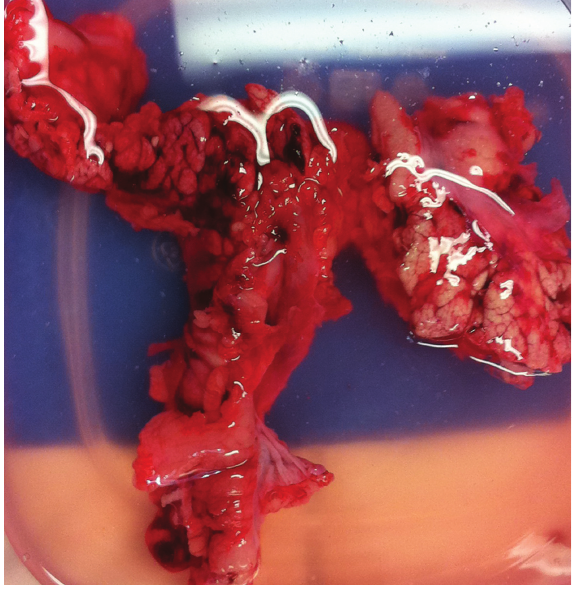
Figure 3: Excised porcine pancreas after